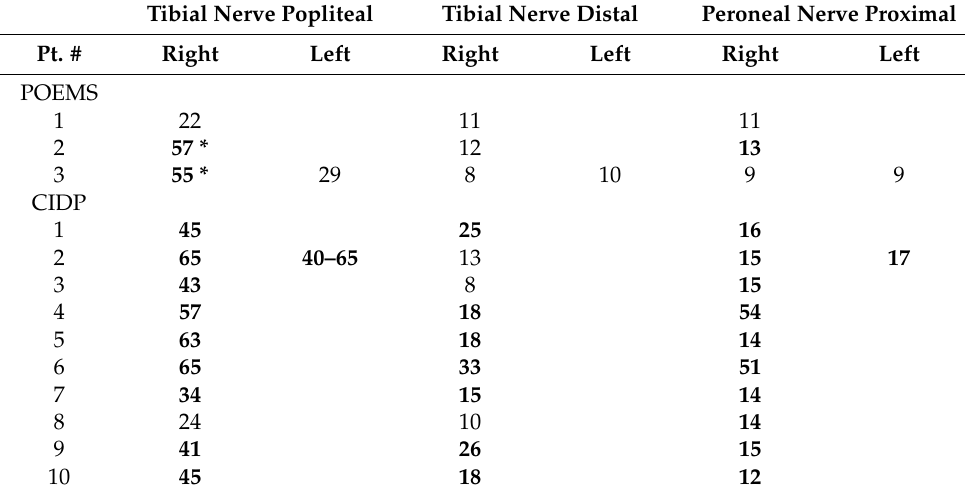
Table 7. HRUS findings in cervical roots (diameter in mm) and vagus nerve CSA values in mm 2 . Diameter of C5 Diameter of C6 CSA of Vagus Nerve Pt. # Right Left Right Left Right